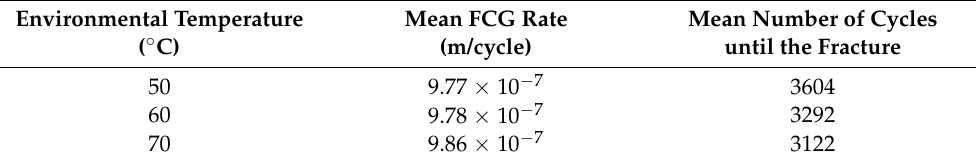
Figure 14. Comparison between the environmental temperatures influence on FCG rate of FDM ABS samples printed with (0.05-, 0.10-, and 0.15-mm layer thickness; 0.4-, 0.6-, and 0.8-mm nozzle sizes; and X, XY, and Y building orientations). Table 8. The mean FCG rate and number of cycles of different environmental temperatures regard- less of other printing parameters.